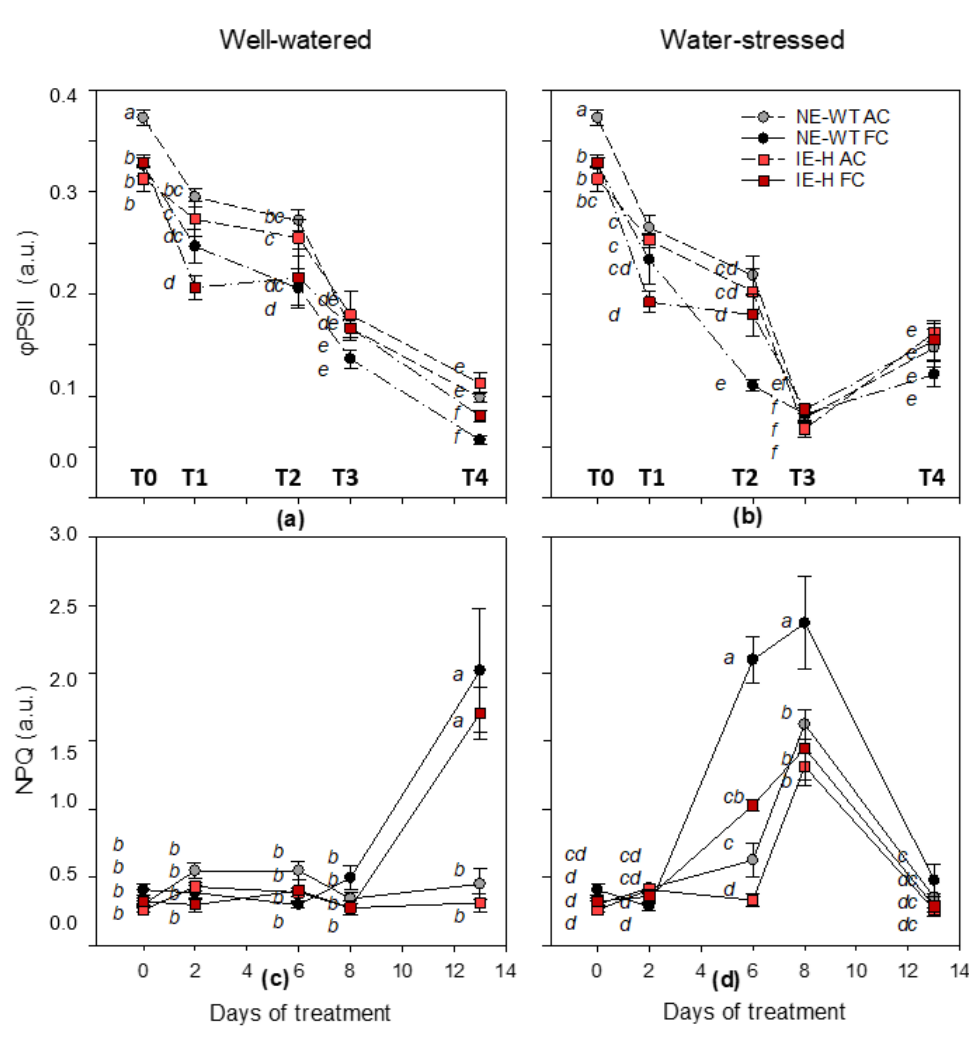
Figure 2. Φ PSII and NPQ time courses. Photochemical efficiency of PSII ( Φ PSII; A, B) and non-photochemical quenching of fluorescence (NPQ; C, D) of non-emitting wild-type = NE-WT (triangles; circles) and isoprene-emitting line = IE-H (diamonds; squares) in actual climate scenario (AC: 400 ppmv and 28 ◦ C; light grey = NE-WT and light red = IE-H) and future climate scenario (FC: 600 ppmv and 32 ◦ C; dark grey = NE-WT and dark red = IE-H) in well-watered WW ( a , c ) and water-stress WS ( b , d ) conditions. Measurements were carried out before imposing the stress at day 0 (=T0), after 2, 6 and 8 days of water stress (WS; T1, T2 and T3, respectively) and after 5 days of recovery by re-watered plants (day 13 = T4). Control plants in well-watered conditions (WW) were also measured along the same time course. Means ( n = 5) + SE are shown for each data point.